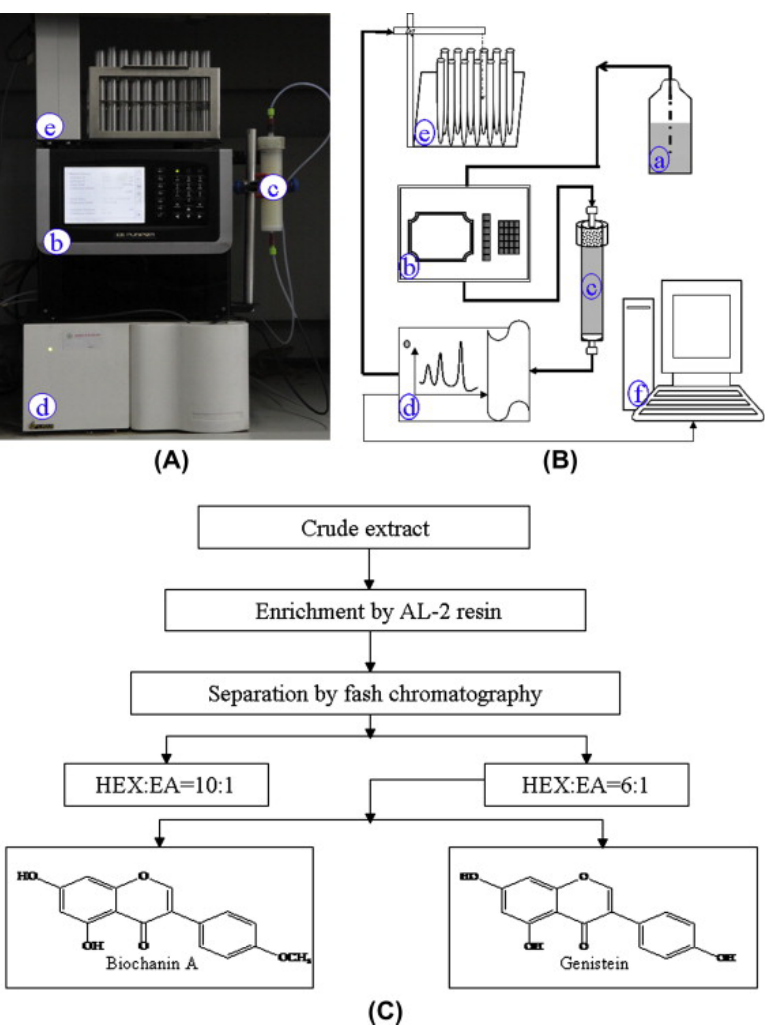
Figure 2. Separation and purification of BCA by flash chromatography. ( A ) A photo and ( B ) a schematic representation of the flash chromatography system: (a) mobile phase; (b) chromatography pump; (c) chromatographic column; (d) UV detector; (e) liquid reservoir; and (f) logger. ( C ) A flow chart depicting the procedures used to purify BCA. Abbreviations: HEX, hexane; EA, ethyl acetate. Reprinted with permission from Ref. [17].